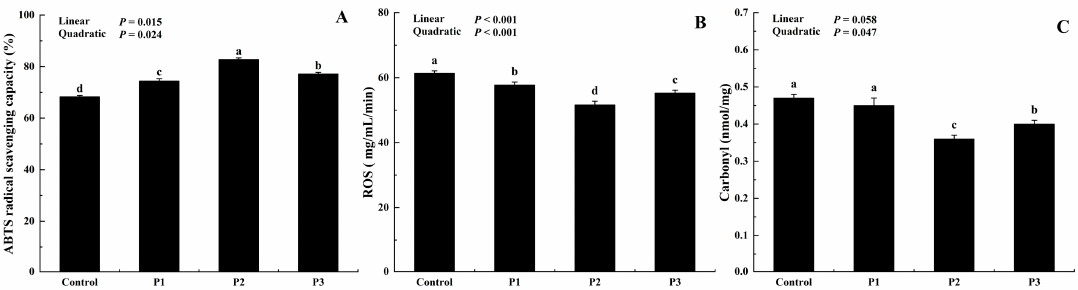
Figure 2. Effect of dietary dried jujube fruit powder (DJFP) supplementation on the antioxidant capacity of the broilers. ( A ) Effect of dietary DJFP supplementation on the ABTS radical-scavenging capacity of the broilers. ( B ) Effect of dietary DJFP supplementation on the ROS content of the broilers. ( C ) Effect of dietary DJFP supplementation on the carbonyl content of the broilers. Control, P1, P2, and P3 diets contained 0, 50, 100, and 150 g/kg DJFP in the diet, respectively. ROS, reactive oxygen species; a–d Values with different letters above the column mean significant difference ( p < 0.05).